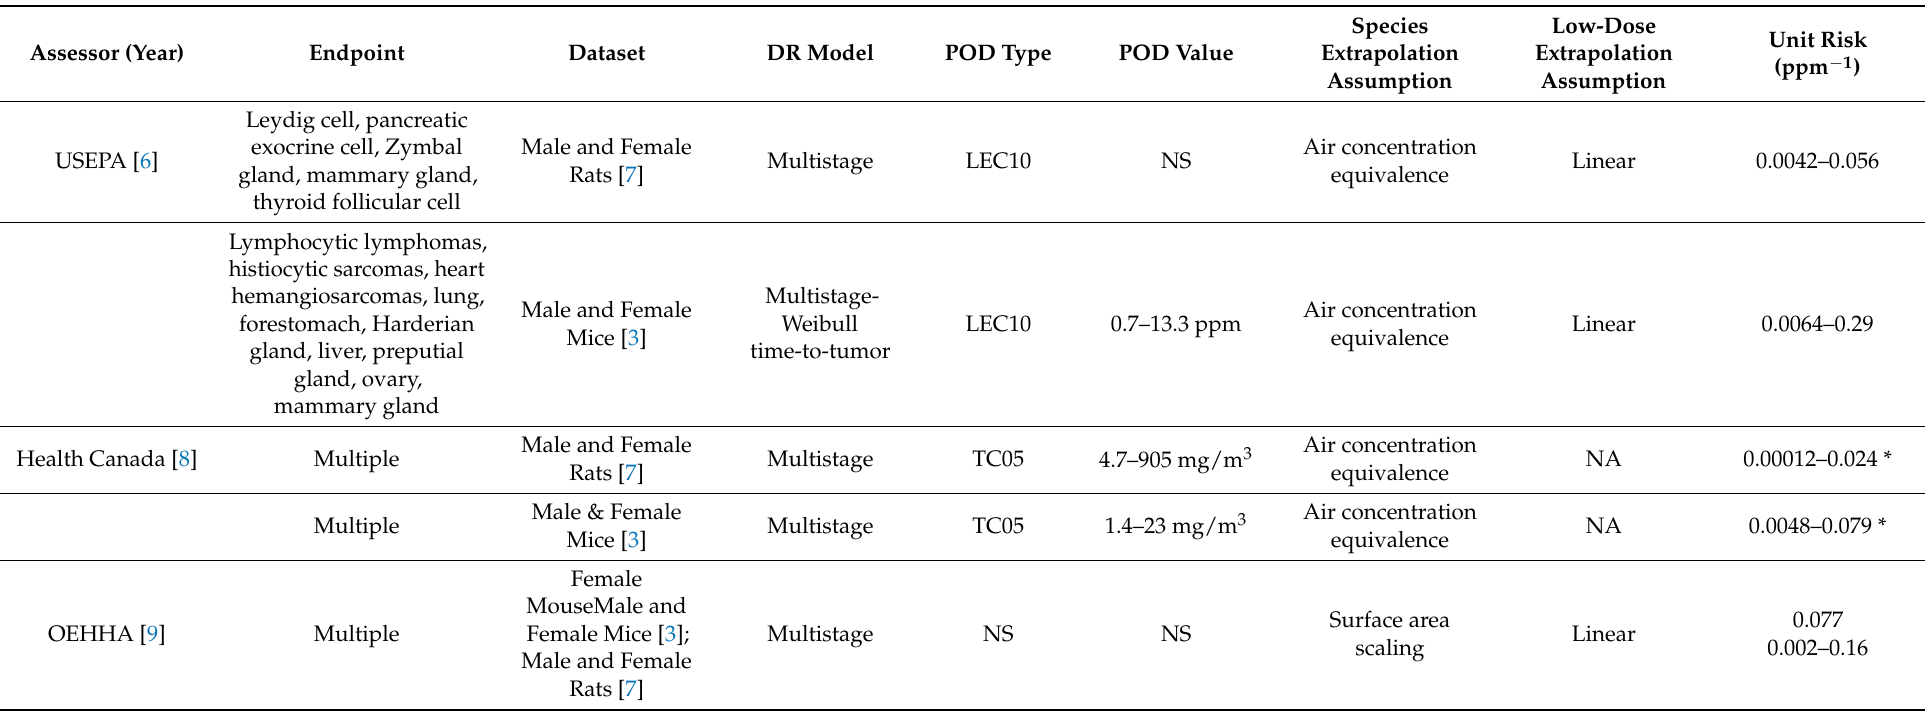
Table 1. Summary of rodent-based cancer risk assessments for